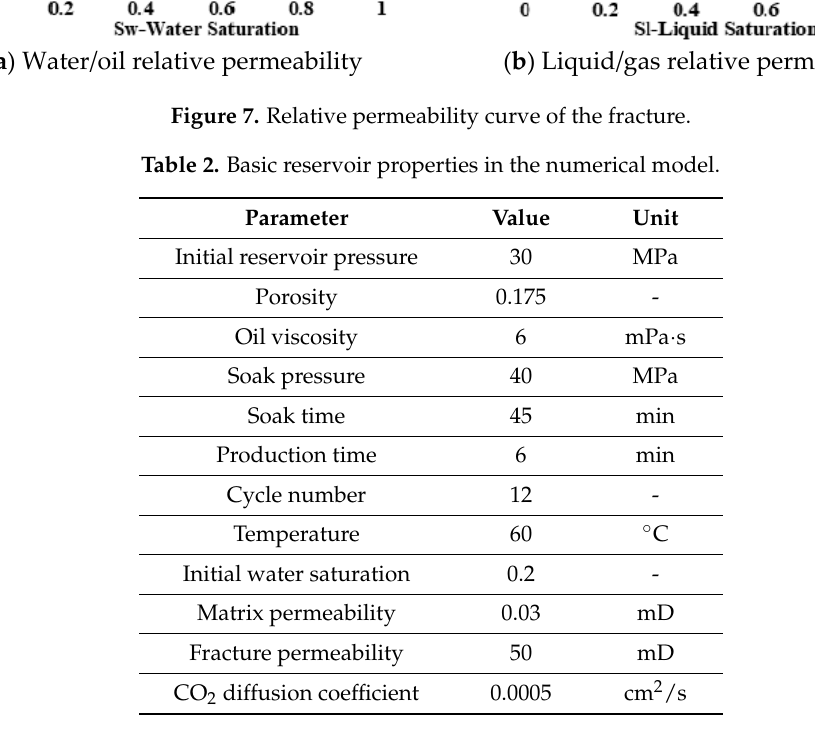
Table 3. Binary interaction parameters